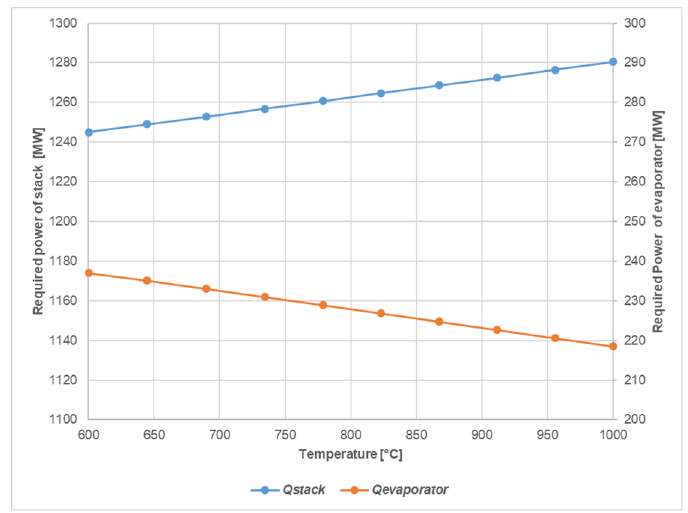
Figure 9. Effect of temperature change in the power requirement of stack and evaporator for 10 kg/s H 2 production.